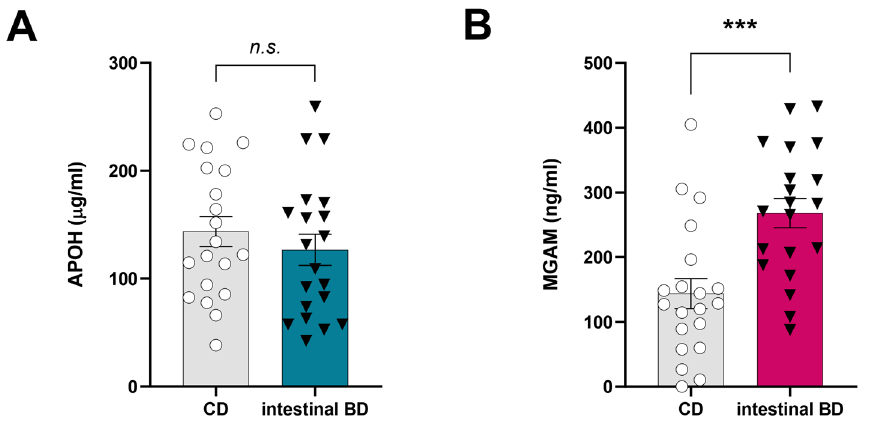
Figure 4. Serum APOH and MGAM protein expression detected using ELISA in intestinal BD patients ( A ) and CD patients ( B ). Results are mean ± SEM; *** p < 0.001. n = 20 patients per each